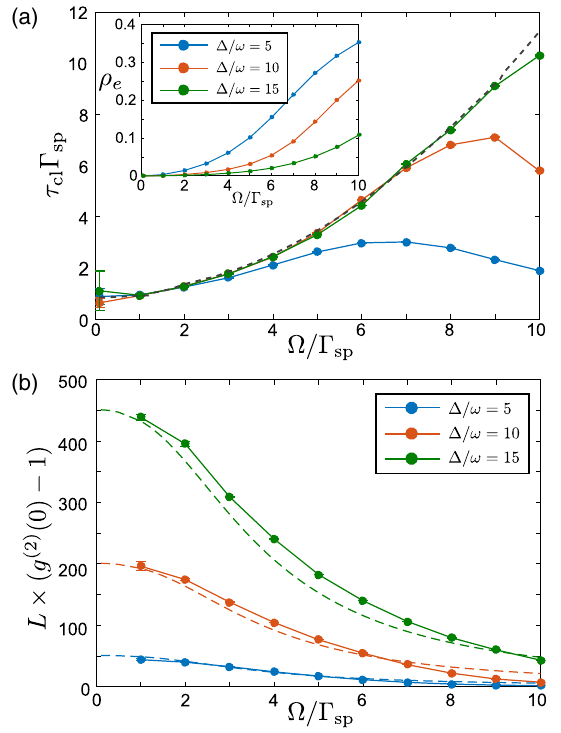
FIG. 11. Numerical simulation of the dynamics using a many- body rate-equation method in a large 1D lattice system with size L ≫ 100 for different detunings Δ over the line width ω ¼ ffiffiffiffiffiffiffiffiffiffiffiffiffiffiffiffiffiffiffiffiffiffiffiffiffiffiffi q γ Ω 2 = γ Γ 1 a . The and fixed facilitation radius r 0 0 sp þ fac ¼ FIG. 12. Interaction potentials of the pair state j 25 P 1 decoherence rate is γ 0 = Ω ¼ 2 . 05 and decay rate is obtained from a diagonalization of the interaction Hamiltonian Γ = Ω ¼ 0 . 1 . (a) Cluster lifetime τ and (b) bunching parameter including up to quadrupole-quadrupole interactions. The different sp cl g ð 2 Þ ð 0 Þ − 1 . The dashed lines are the results from the cluster potentials correspond to different superpositions of the m 2 = 8 as the effective coordination ≃ 2 þ ð Ω = Γ model using z The green dashed line is a fit to the only repulsive potential with eff sp Þ V ð r Þ ¼ C 9 =r 9 and C 9 ¼ 2 π × 2 . 1 kHz μ m 9 number.